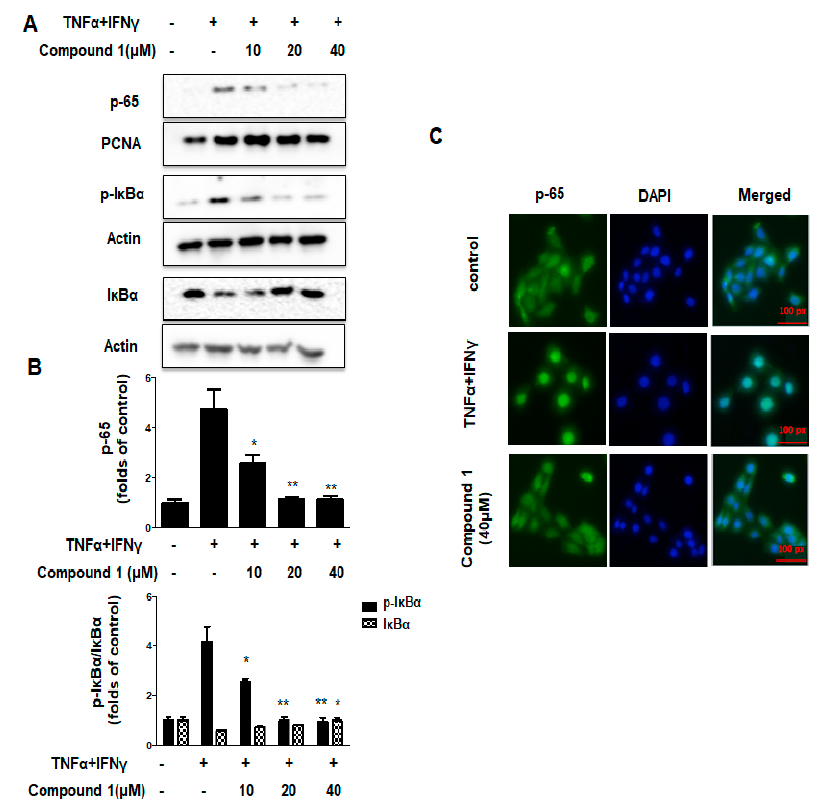
Figure 6. Effects of compound 1 on NF- κ B signaling pathways in HaCaT cells ( A – C ). The expression of p65, p-I κ B α , and I κ B α in the fractions were determined by using Western blotting. Immunofluorescence assay was performed as described in the methods section. Data are represented as the mean ± SD (n = 3). * p < 0.05, ** p < 0.01, vs. TNF- α /IFN- γ -treated group.